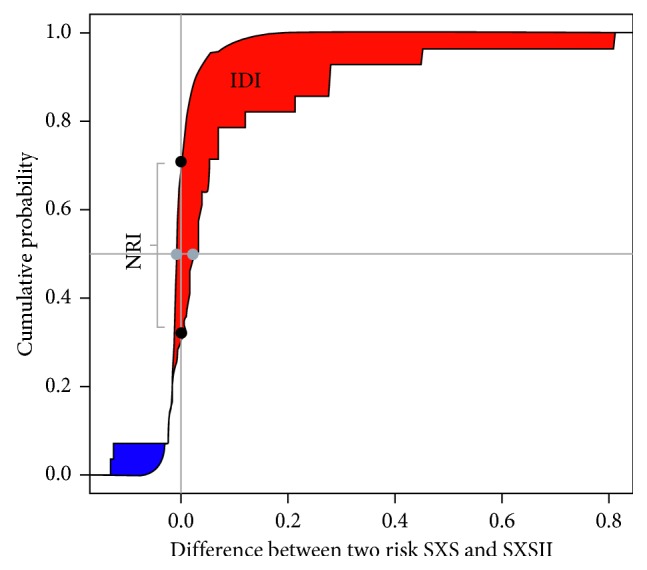
Category-free IDI and NRI. The red shaded area shows a significant integrated discrimination improvement (IDI), whereas the difference between the two vertical dots represents the improvement in net reclassification by SXSII over SxS.